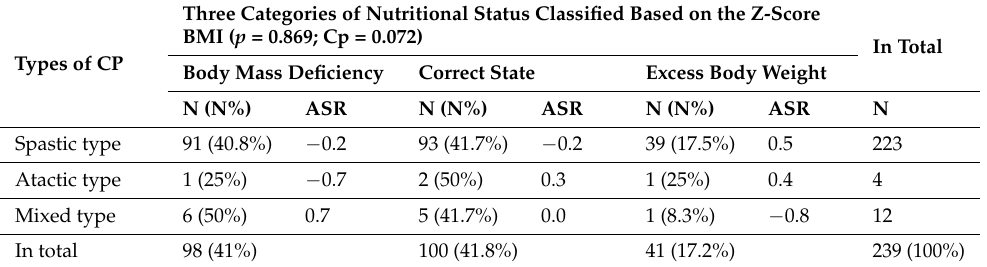
Table 12. Relationship between three categories of nutritional status classified based on the BMI z-score and types of CP.